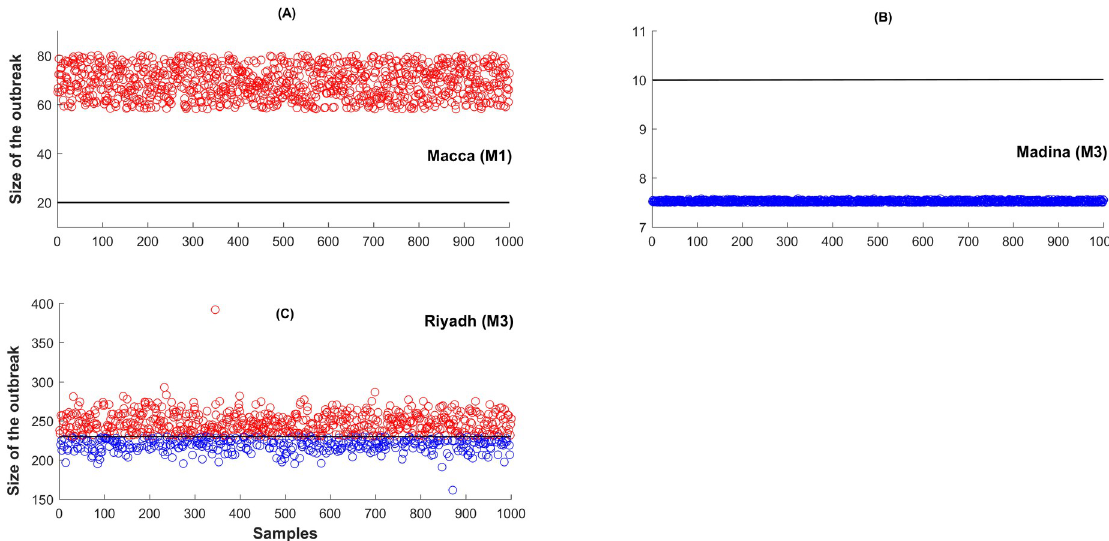
Fig 6. Out-of-fit prediction of large outbreaks in Macca, Madina and Riyadh in July 2016 to July 2017. Large outbreak size (red circles) are defined as those samples which exceeds previous year (July 2015 to July 2016) total season cases. Blue circles denote those samples that fall below previous year total cases. The black line denotes total cases during July 2015 to July 2016 of the data. M1: two strain model with bilinear incidence, M3: two strain model with saturated